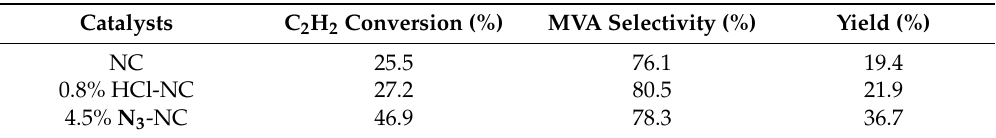
Figure 2. Lifetime testing of NC, 4.5% N 3 -NC and 0.8% HCl-NC. Table 2. Effect of NC, 4.5% N 3 -NC and 0.8% HCl-NC on acetylene conversion and MVA selectivity in acetylene